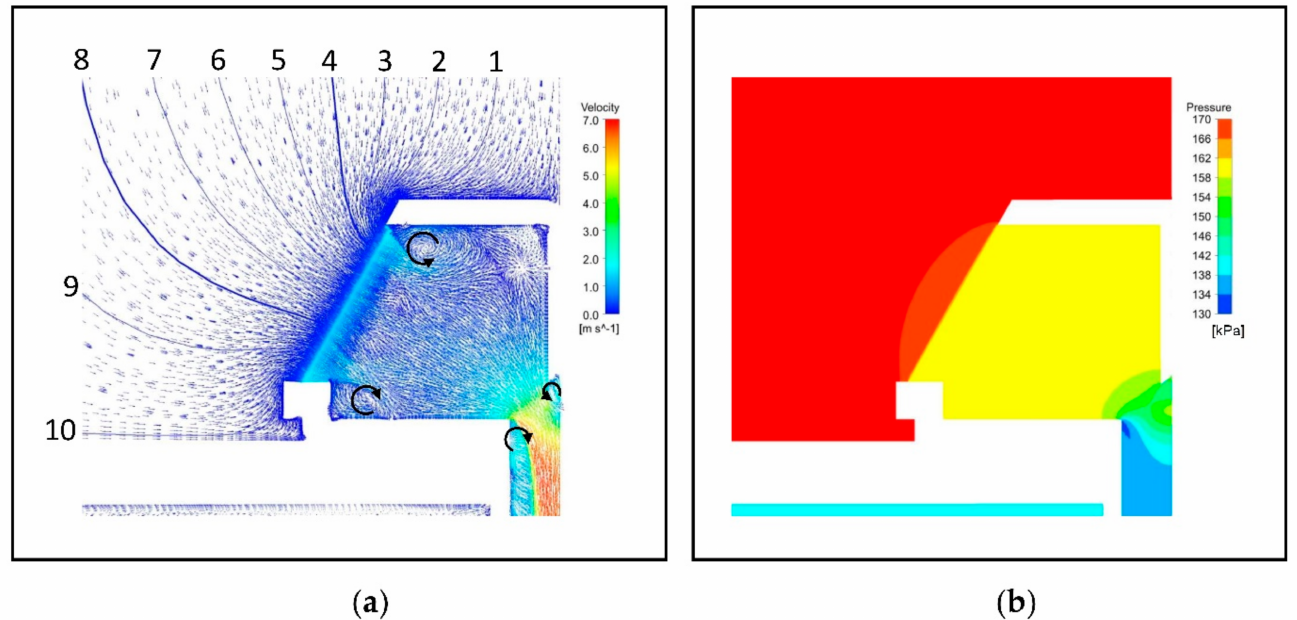
Figure 11. ( a ) Velocity vectors and ( b ) pressure contours at the underdrain region for case SS1 with Ergun model, Q = 0.8 L s − 1 , h s = 317 mm in a vertical plane at 44 ◦ angular position from the symmetry plane (crosses through the middle of a